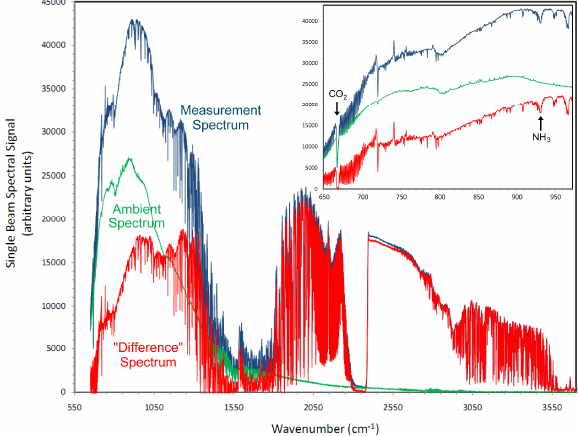
Fig. 4. Single beam measurement spectrum (blue) collected by the FTIR spectrometer viewing the IR Source across a 170 m smoke-filled optical path during Fire 1. Also shown is an ‘ambient’ spectrum (green) collected without the IR source, together with the resulting “difference” spectrum (red) calculated according to Müller et al. (1999) to remove the effect of ambient emission (including instrument self-emission) from the measurement spectrum prior to trace gas retrieval. The inset focuses on the spectral range where the ambient spectrum has most significance (i.e. lower wavenumbers). The 668 – 670 cm -1 CO 2 absorption band is correctly seen to show zero signal in the “difference” spectrum, whilst the primary 925 – 934 cm -1 absorption feature used here to retrieve NH 3 column amounts is clearly apparent in both the measurement and difference spectra.